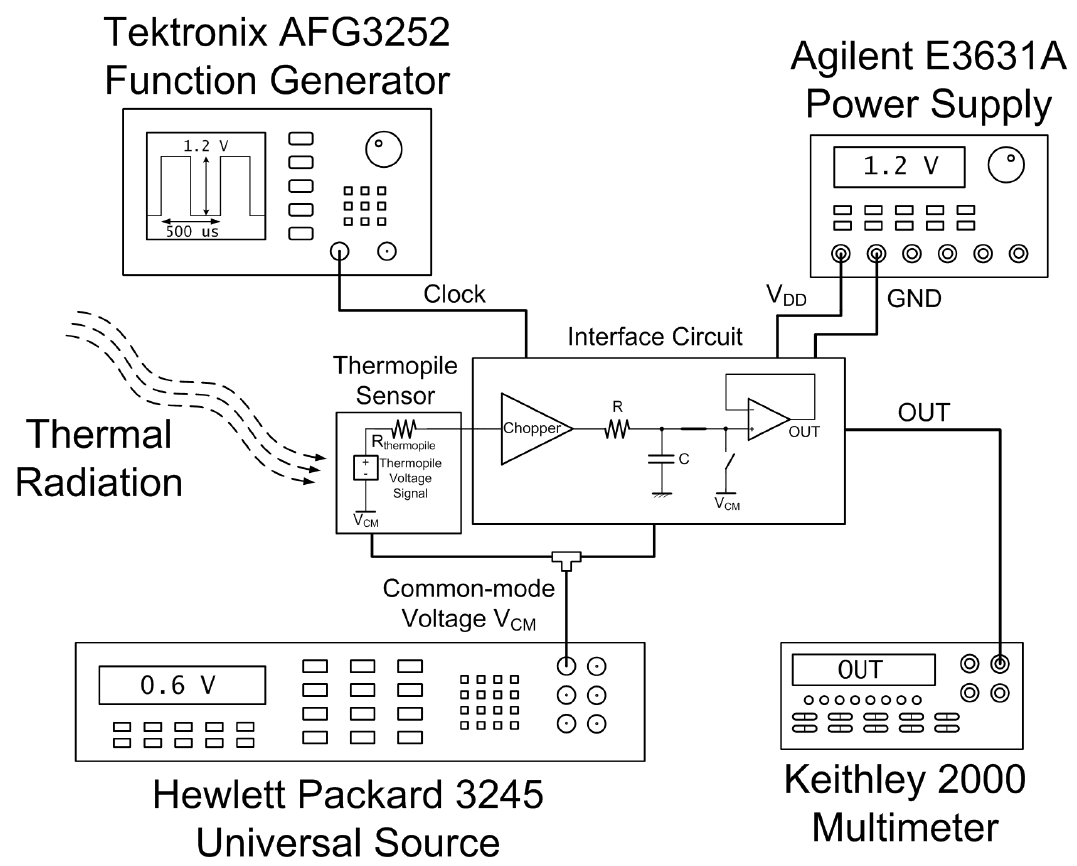
Figure 12. Schematic view of the measurement